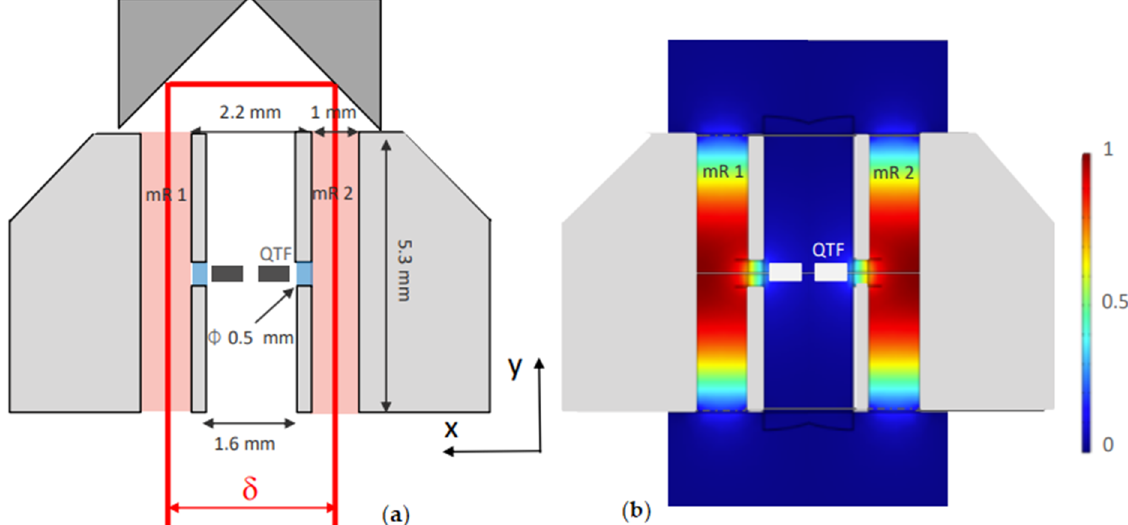
Figure 4. ( a ) Detailed dimensions of the monolithic double mR. The laser beam is represented in red. It is reflected by the right angle mirrors. ( b ) Normalized acoustic pressure generated into the double mR for f = 32,815 Hz, corresponding to the QTF resonant frequency.